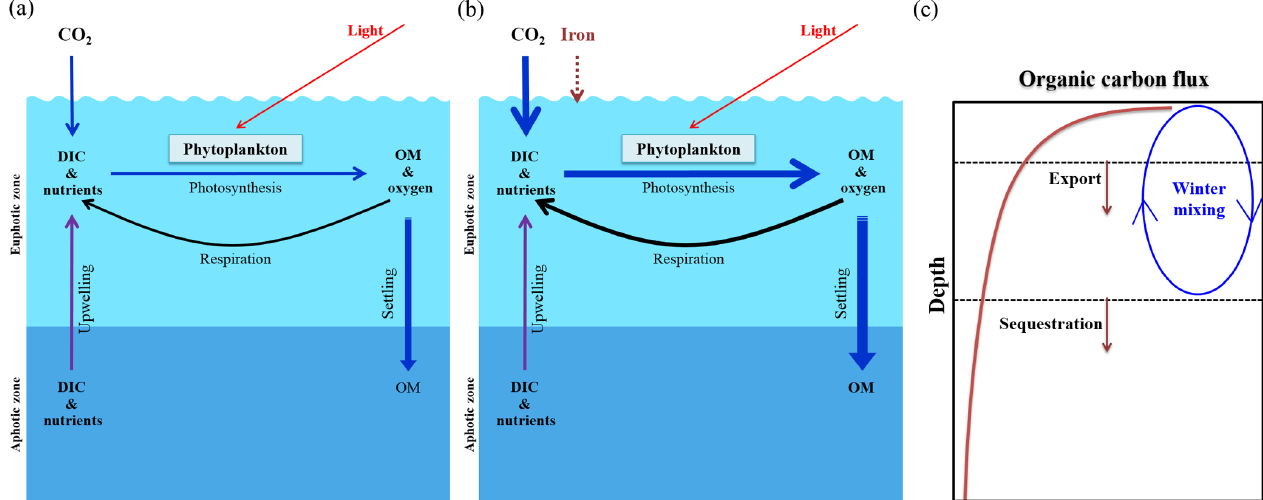
Figure 3. The iron hypothesis, as suggested by Martin (1990). (a) Effectiveness of the biological pump under normal conditions. (b) Ef- fectiveness of the biological pump following iron enrichment (modified from Sarmiento and Gruber, 2006). (c) Schematic diagram of the decrease in the downward flux of organic carbon as a function of depth in the water column (modified from Lampitt et al., 2008). OM is organic matter and DIC is dissolved inorganic